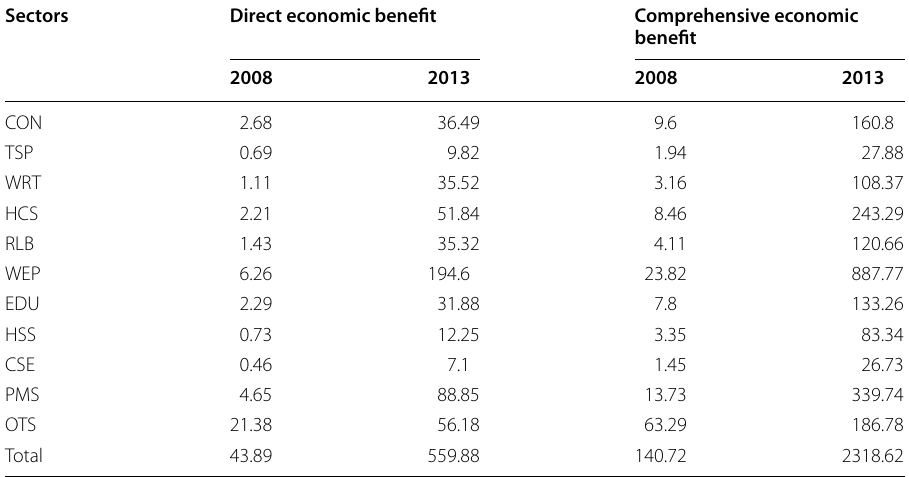
Table 5 Direct and comprehensive economic benefits of South‑to‑North Water Diversion to Beijing (unit RMB 100 million)